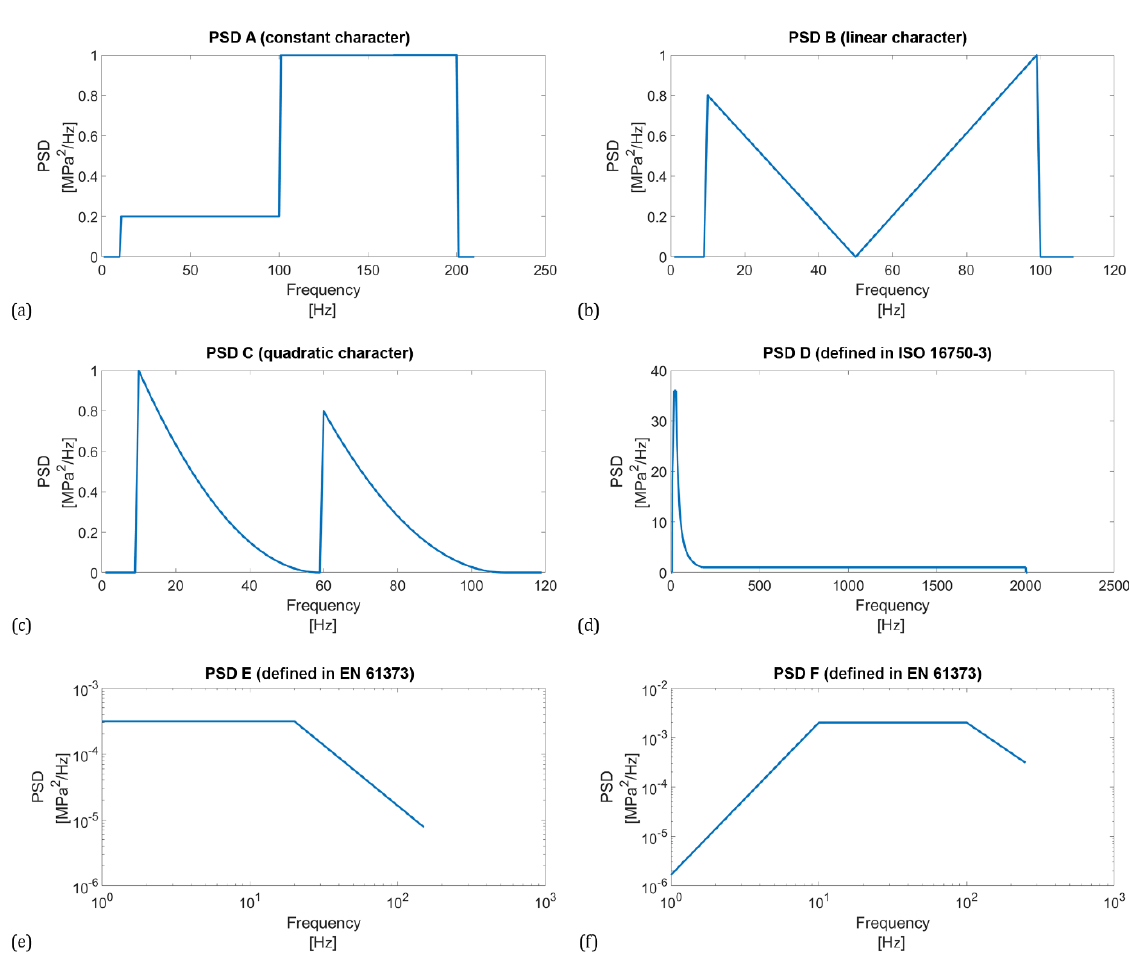
6 of 21 Figure 1. Design of experiment flow chart.